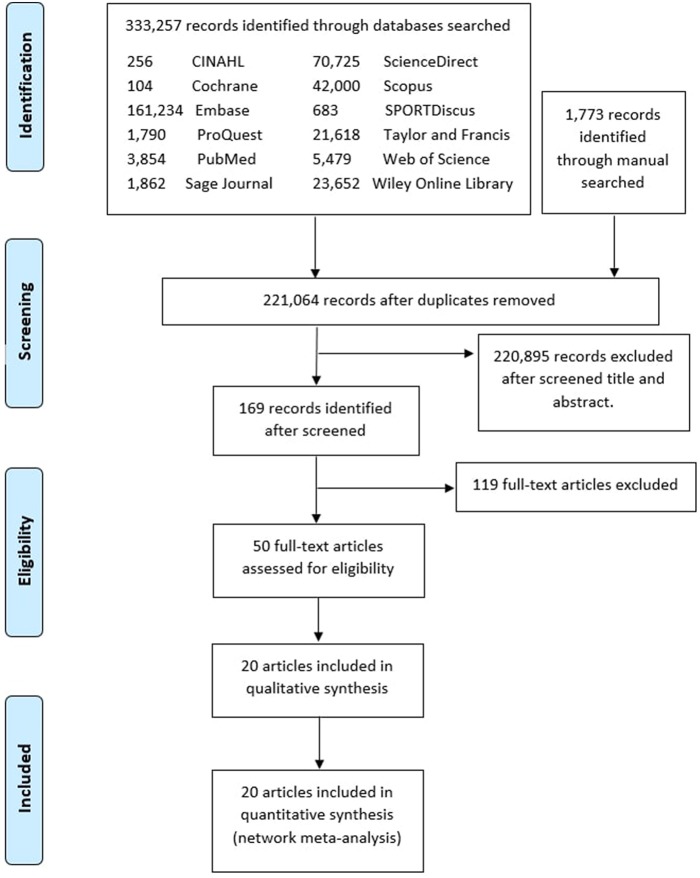
PRISMA flow diagram.